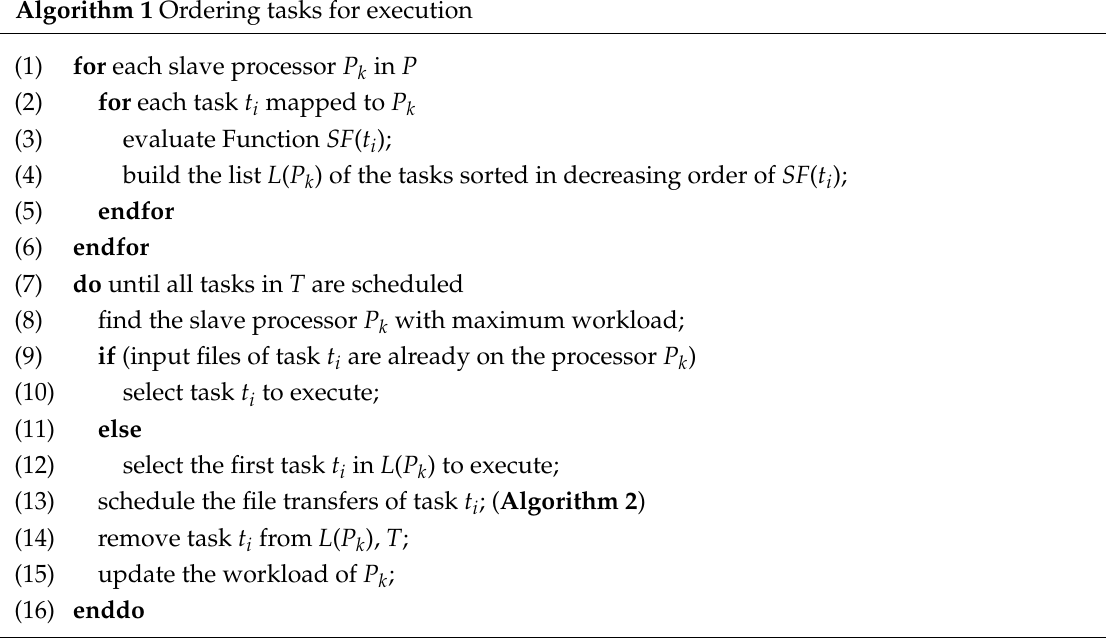
Algorithm 1 Ordering tasks for execution